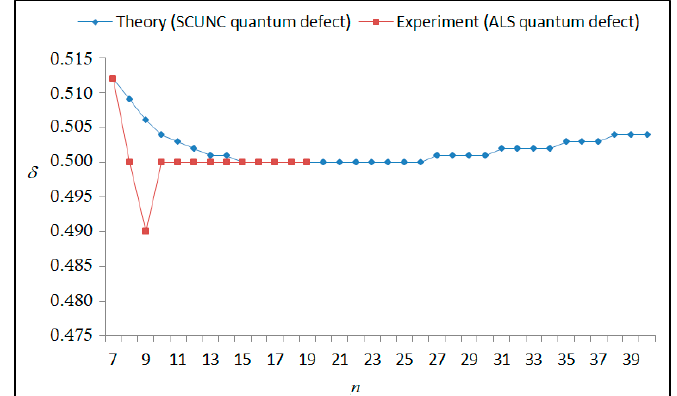
Figure 7. Variations of the quantum defect ( δ ) with the principal quantum number n for the 4 s 2 4 p 2 ( 1 D 2 ) ns Rydberg series originating from the 2 P ° 3/2 metastable state of Se + converging to the 1 D 2 series limits in Se 2+ .